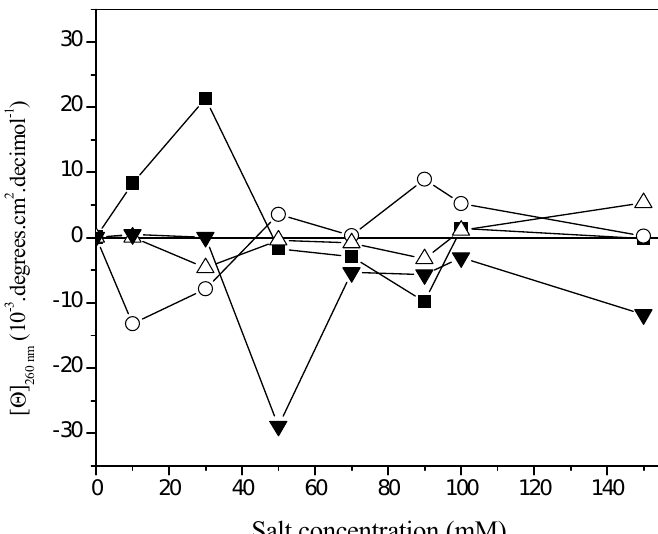
Figure 5. Effect of Hoffmeister series ions concentrations on θ of 7.36 mM Dtxd were obtained after emulsification in the presence of CH (o) and NaCl ( ∆ ) or the chaotropics KSNC ( (cid:132) ) and MgCl kosmotropics NaHPO 4 CD spectra were recorded (cuvettes of 0.1 cm path